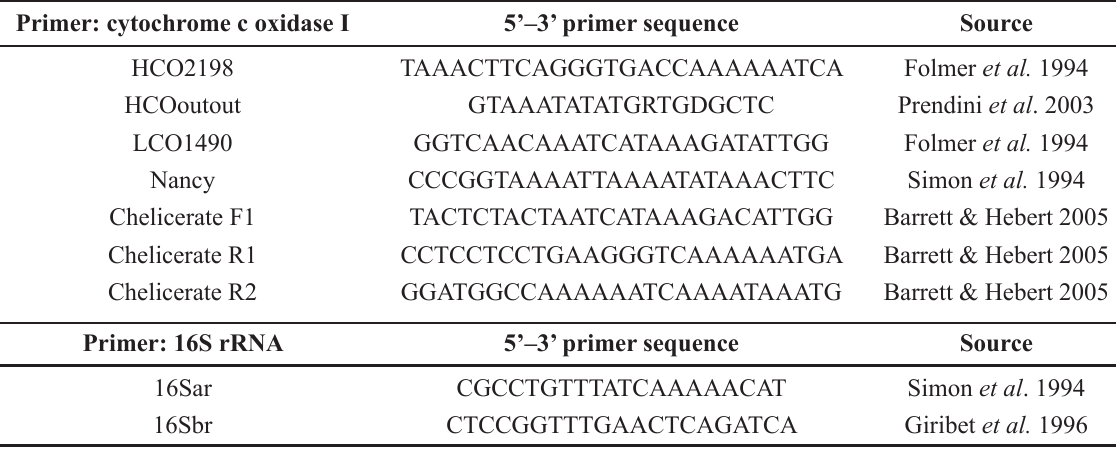
Table 5. Primers used for PCR amplification and sequencing of COI and 16S mitochondrial genes . Primer: cytochrome c oxidase